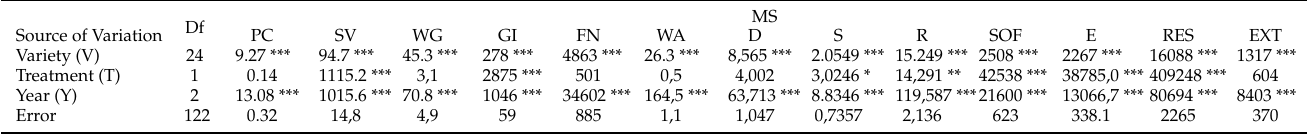
Table 2. Analysis of variance for five grain technological and eight dough rheological properties in the three years of